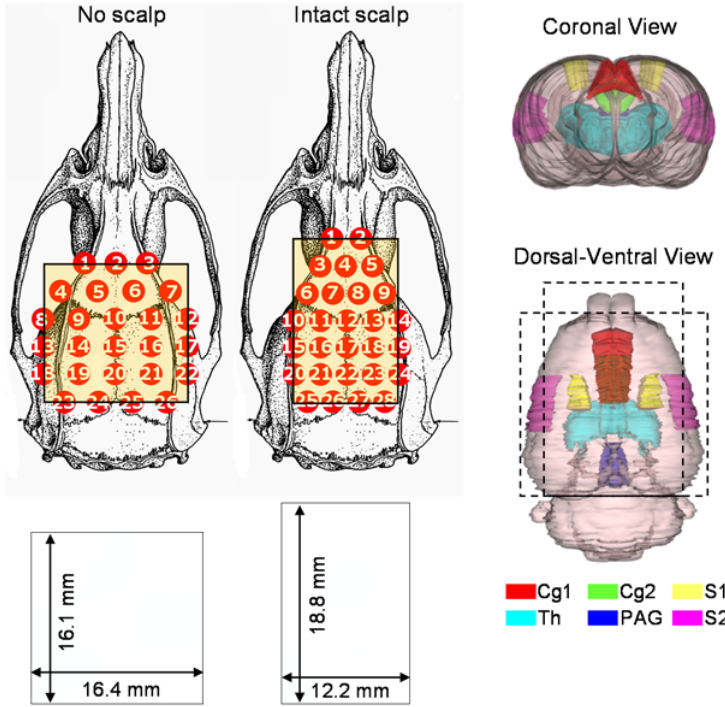
Figure 1. Optode-array placements in the no-scalp ( left ; [12]) and intact-scalp ( right ) groups. The sizes ( bottom ) of reconstructed images were dependent on array